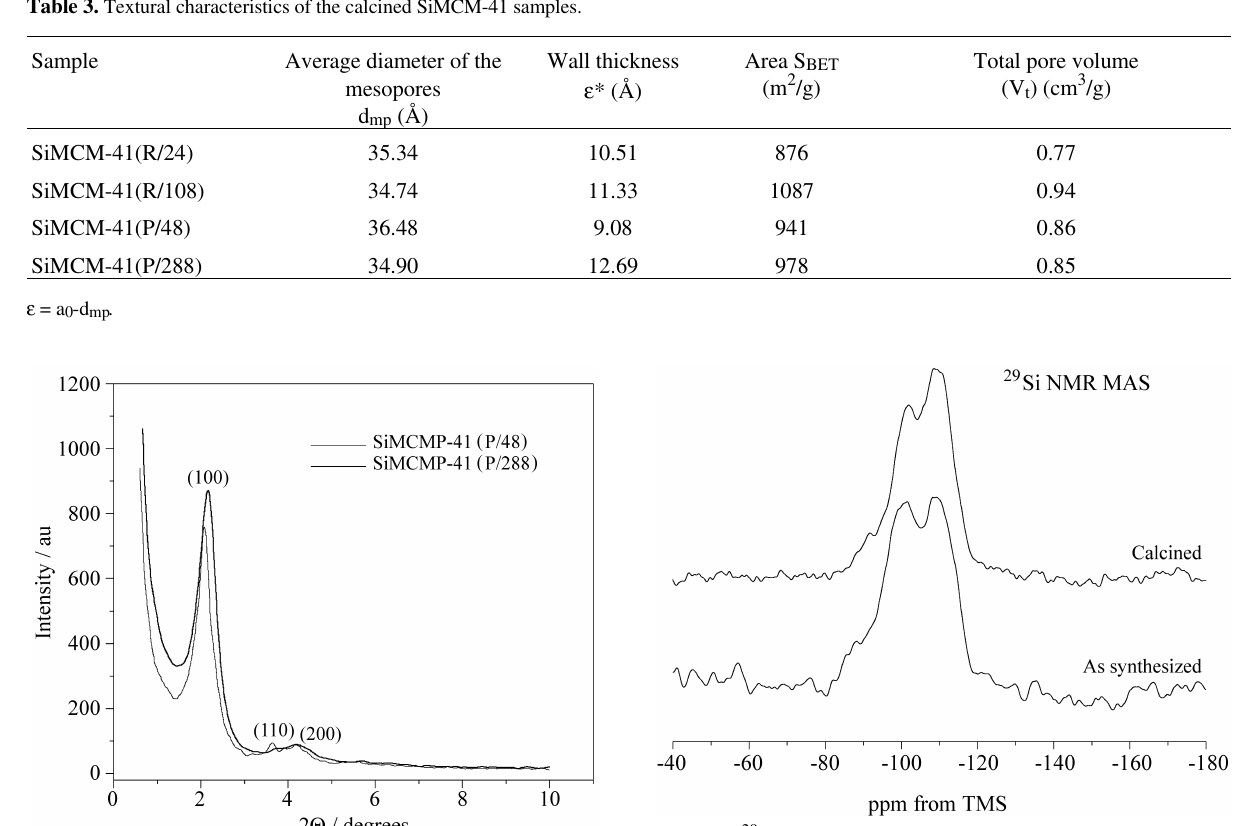
Figure 6. 29 Si MAS NMR spectra of the AlSiMCM-41 (R/108) samples.